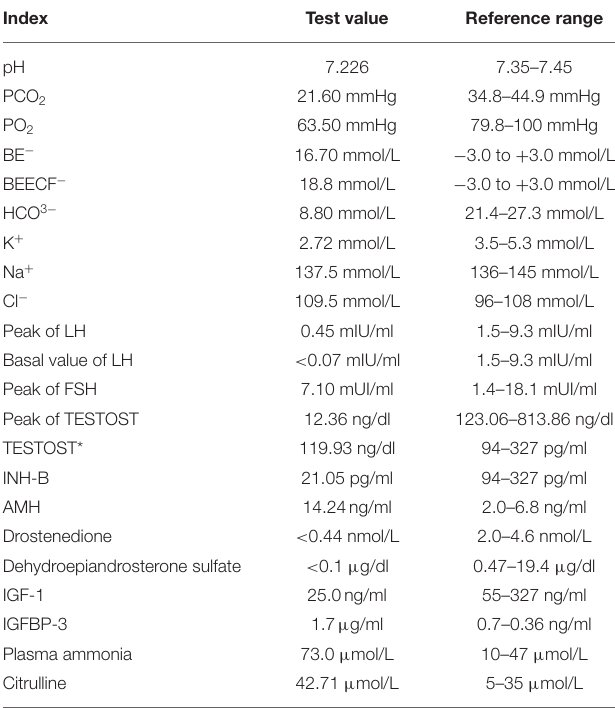
TABLE 1 | Laboratory test results and reference range of the